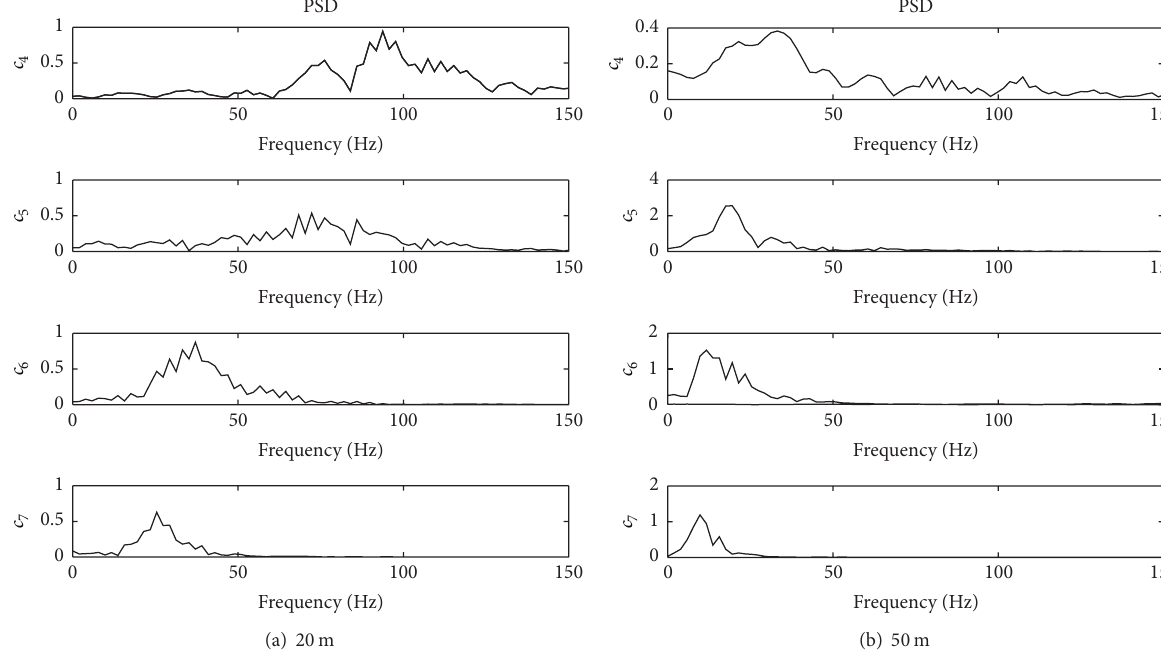
Figure 14: Spectrogram of components 𝑐 4 ∼𝑐 7 of EMD decomposition at different measuring points.